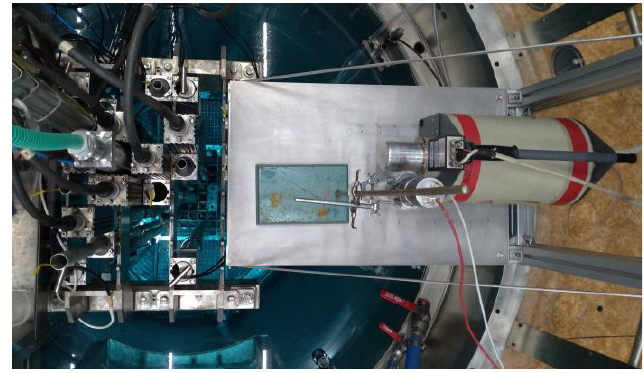
Fig. 2 Photography of measurement geometry